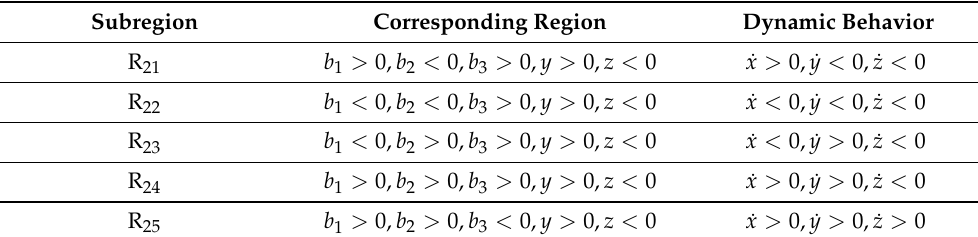
Table 5. Dynamic behavior of the trajectories in the five subregions. Subregion Corresponding Region Dynamic Behavior R